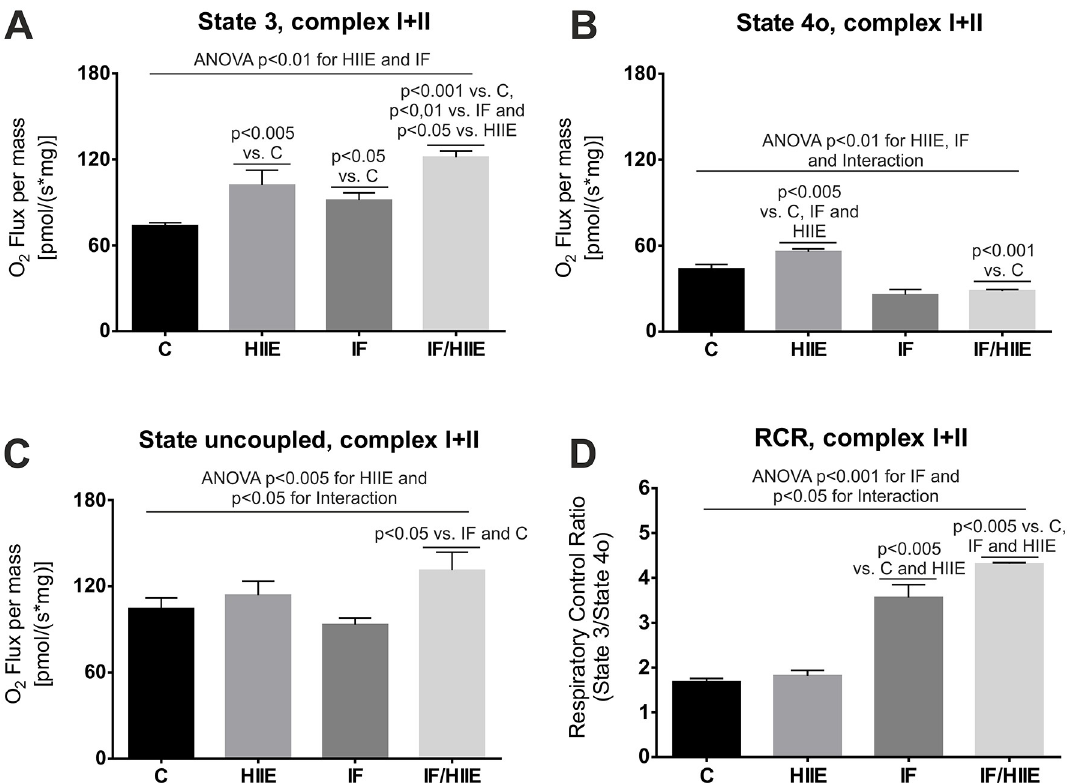
Fig 6. IF/HIIE promotes mitochondria activation in permeabilized skeletal muscle fiber bundles. Respiration measurements were performed on gastrocnemius fiber bundles using a high-resolution respirometry. The results were normalized to the wet weight of the permeabilized fiber bundles. (A) State 3 O 2 flux. State 3 was measured after addition of complex I and II substrates and ADP. (B) State 4o O 2 flux. State 4o was measured subsequently to the State 3 after addition of oligomycin to mimic real State 4 (depletion of ADP). (C) State uncoupled O 2 flux. State uncoupled was measured in the sequence of state 3 and state 4o through addition of FCCP. (D) RCR calculation. RCR was calculated by State 3 divided by State 4o. Each bar represents the mean ± SD; A-D) n = 3. Individual effects (IF and HIIE) and the effect of their interaction were verified by two-way ANOVA and multiple comparisons; p values were annotated.